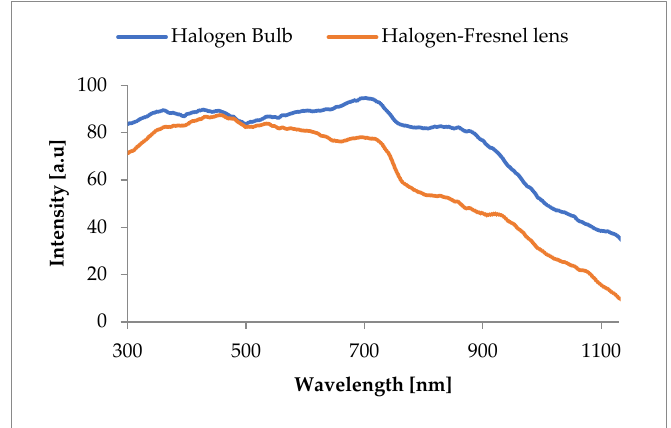
Figure 3. The halogen bulb and before the mirror (after FL) spectrums (a.u. is arbitrary units).